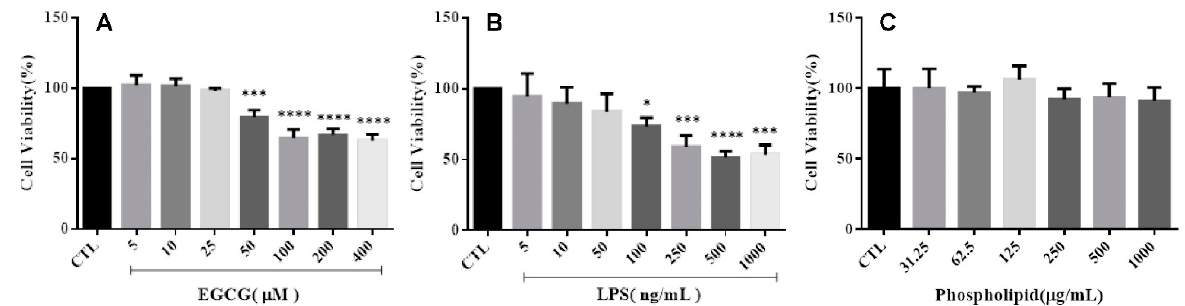
Figure 1. Cell viability of BV-2 cells treated by ( A ) EGCG, ( B ) lipopolysaccharide (LPS), and ( C ) placebo liposome (compared with control group (CTL), * p < 0.05; *** p < 0.001, **** p < 0.0001, n = 3).